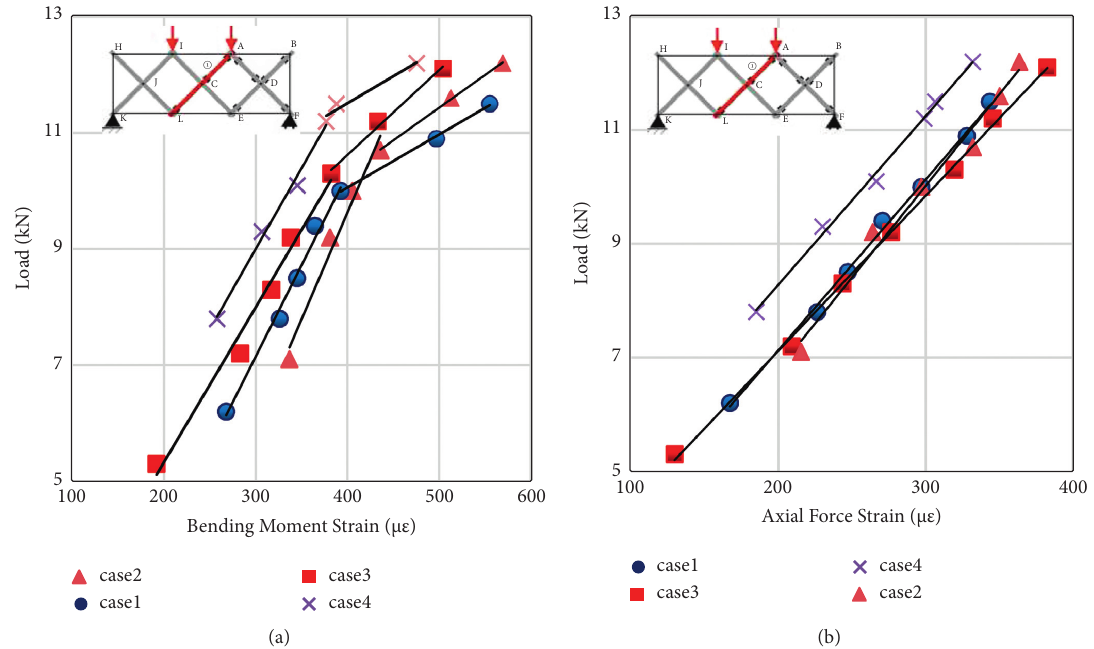
Figure 10: Load-internal force strain curve of bar 1 in the cable-strengthened structure: (a) load-bending strain curves and (b) load-axial strain curves.